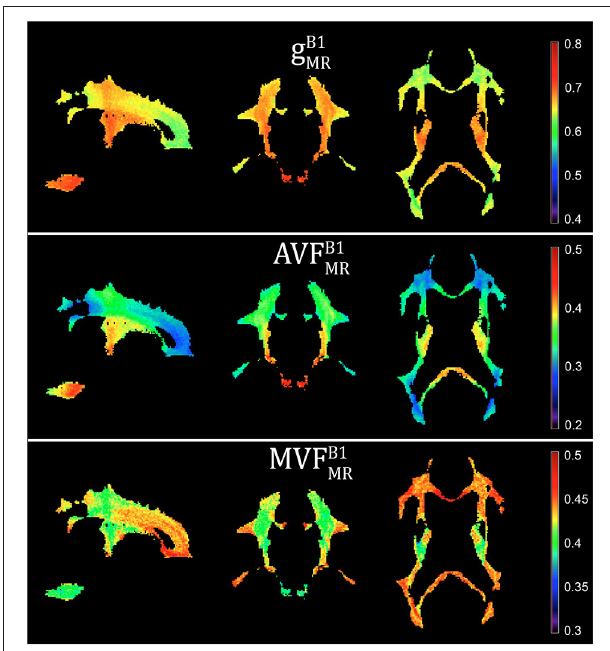
FIGURE 5 | Voxel-wise maps of group-averaged g B1 MR , AVF B1 MR , and MVF B1 MR , restricted to the group WM mask (cf. section “Definition of White Matter Masks”). Depicted are a single sagittal (x = 100), coronal (y = 91), and axial (z = 85)